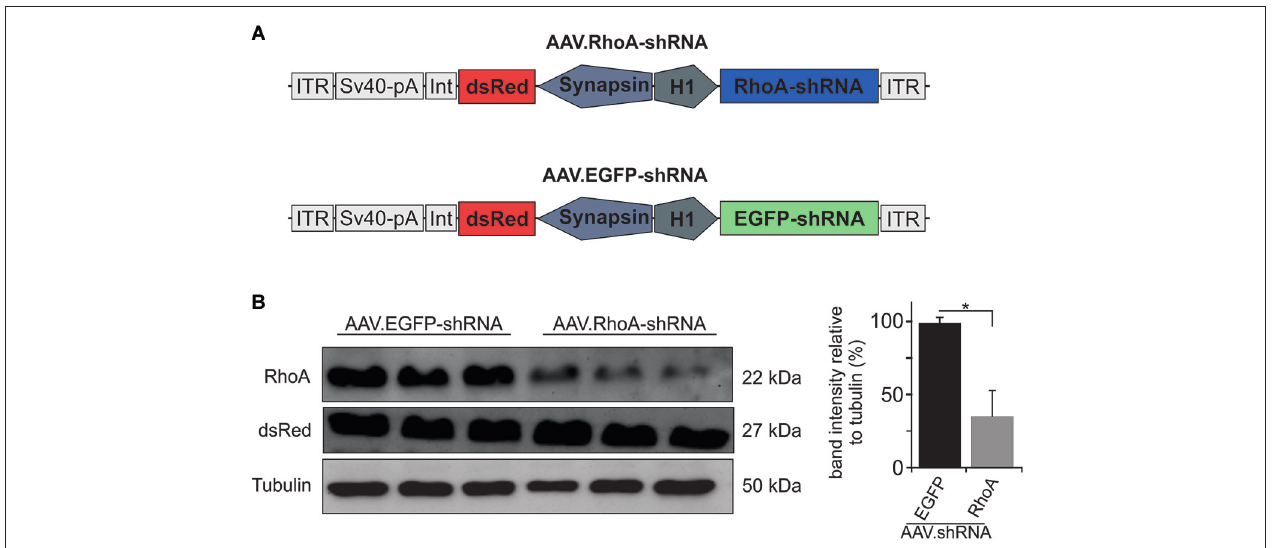
SV40-pA: SV40 polyadenylation site. (B) Immunoblots for RhoA and dsRed of primary hippocampal neurons transduced with AAV.RhoA-shRNA or AAV.EGFP-shRNA ( n = 3 independent protein lysates per group; bars represent means ± SEM: * p < 0.05 according to Student’s t